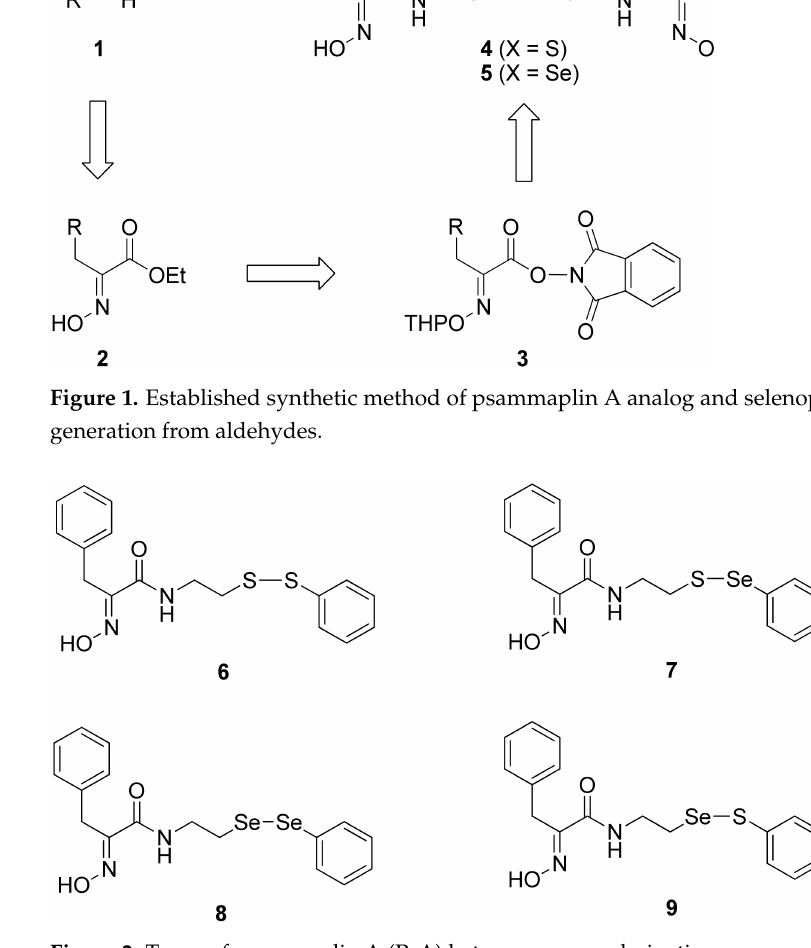
Figure 2. Types of psammaplin A (PsA) heteromonomer derivatives.